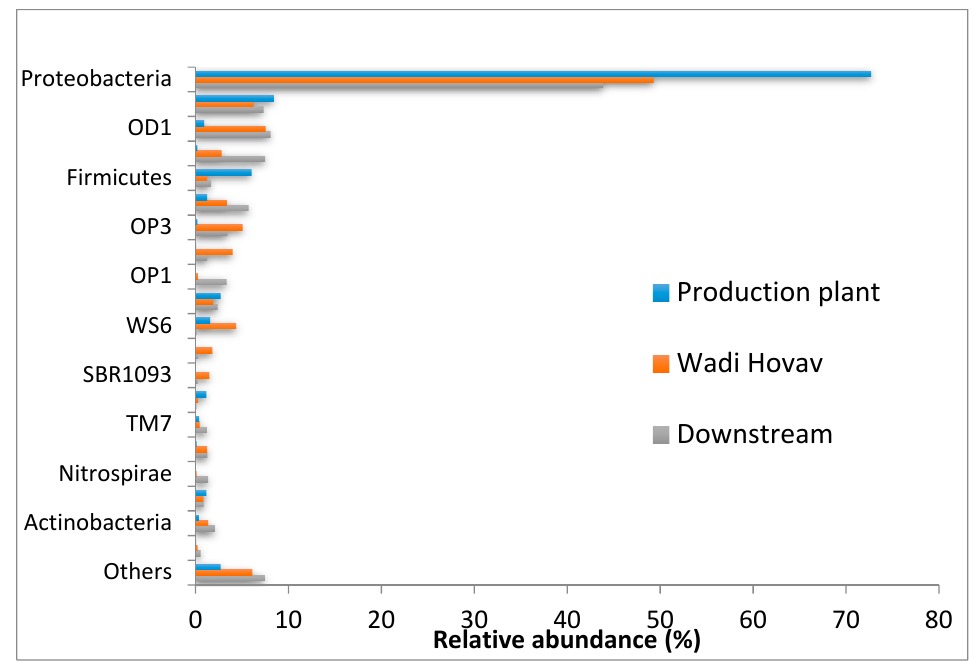
Figure 4. Relative abundance (%) of dominant phyla (>1% abundance) in the three locations of the industrial area-production plant (blue bars); Wadi Hovav (red bars); and downstream (green bars).